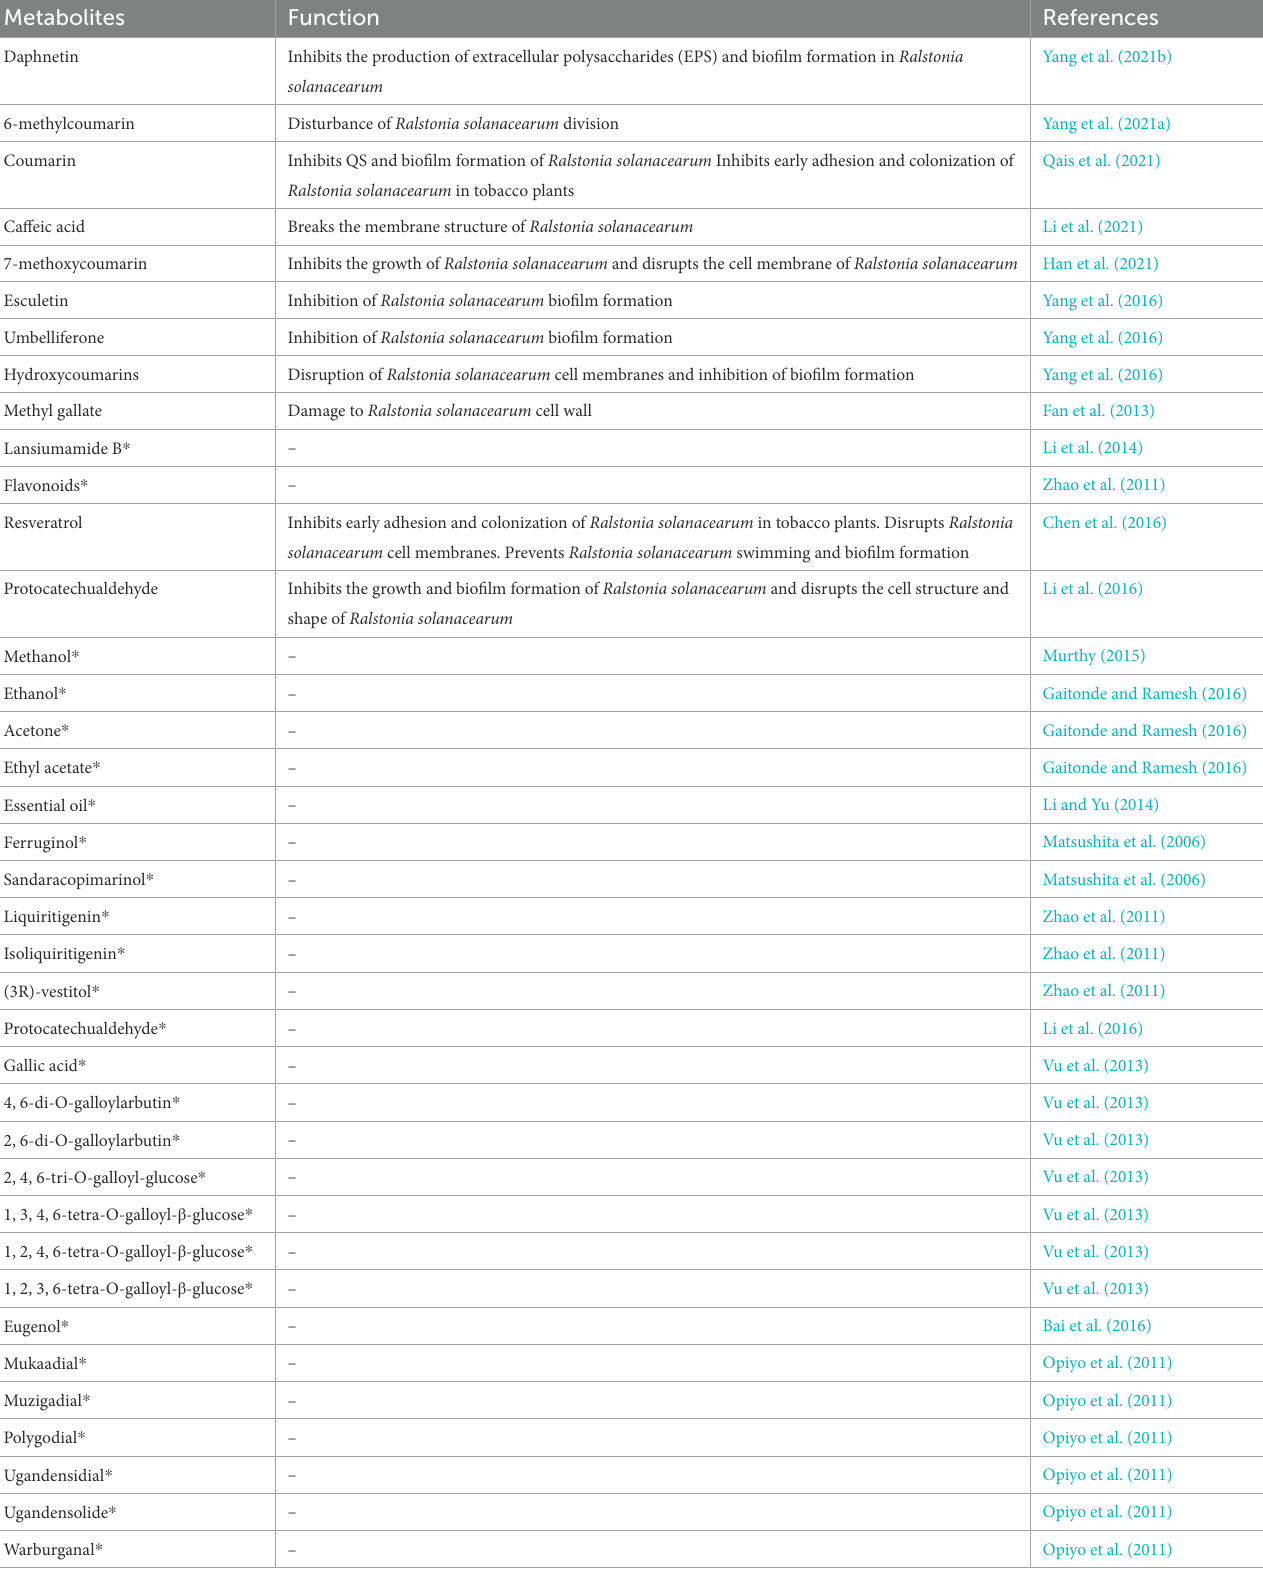
TABLE 1 Role of plant resistance metabolites in resistance to Ralstonia solanacearum